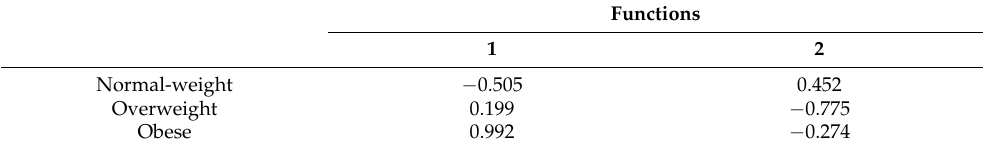
Table 4. Functions at group centroids.